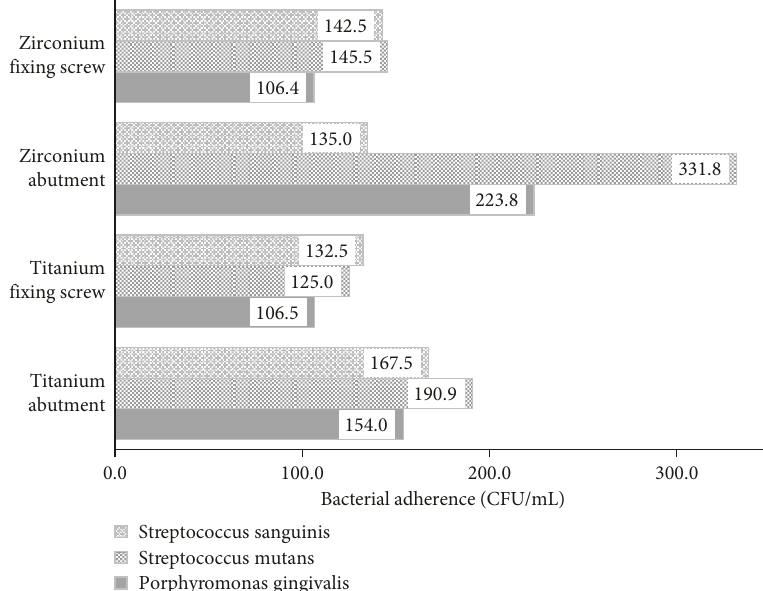
Figure 2: In vitro evaluation of bacterial adherence of Streptococcus mutans (ATCC 25175), Streptococcus sanguinis (ATCC 10556), and Porphyromonas gingivalis (ATCC 33277) on the surface of zirconium/titanium abutment dental implants and fixing screw (CFU � colony- forming